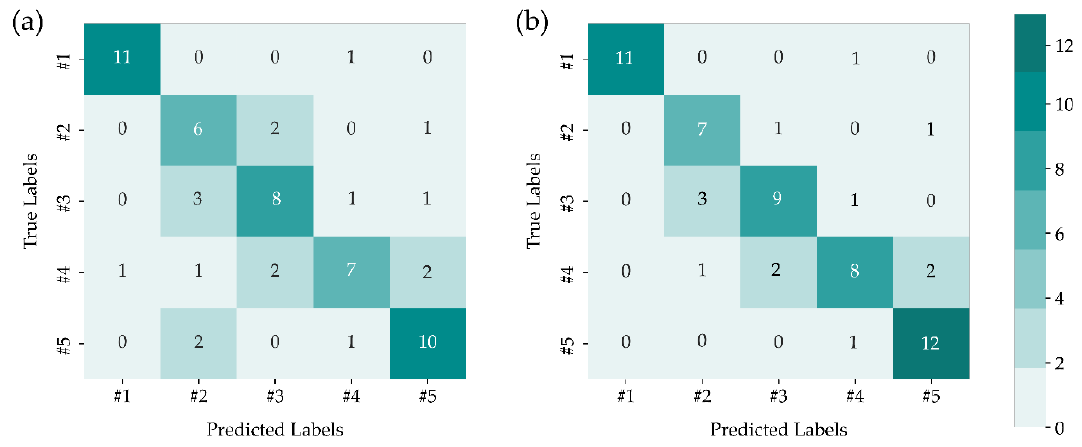
Figure 3. Confusion matrices for ( a ) PCA-SVM and ( b ) MDS-SVM models.